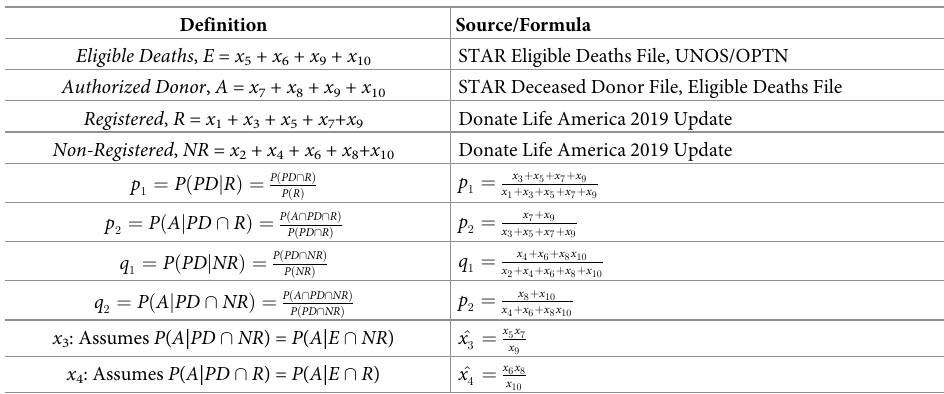
Table 7. Data sources and